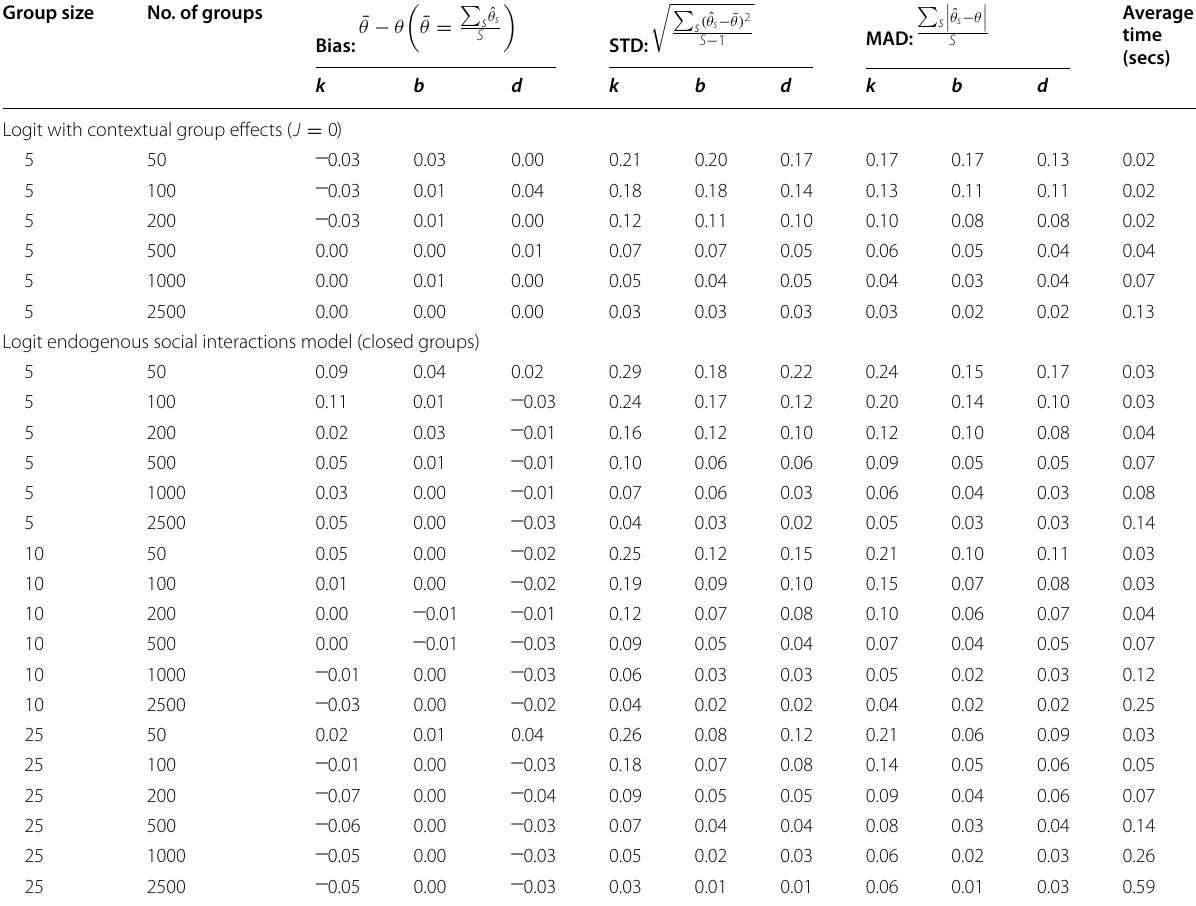
Table 1 Bias, standard deviation and mean absolute deviation of the estimates of the logit discrete choice model with contextual group effects and the logit endogenous social interactions model with closed groups Group